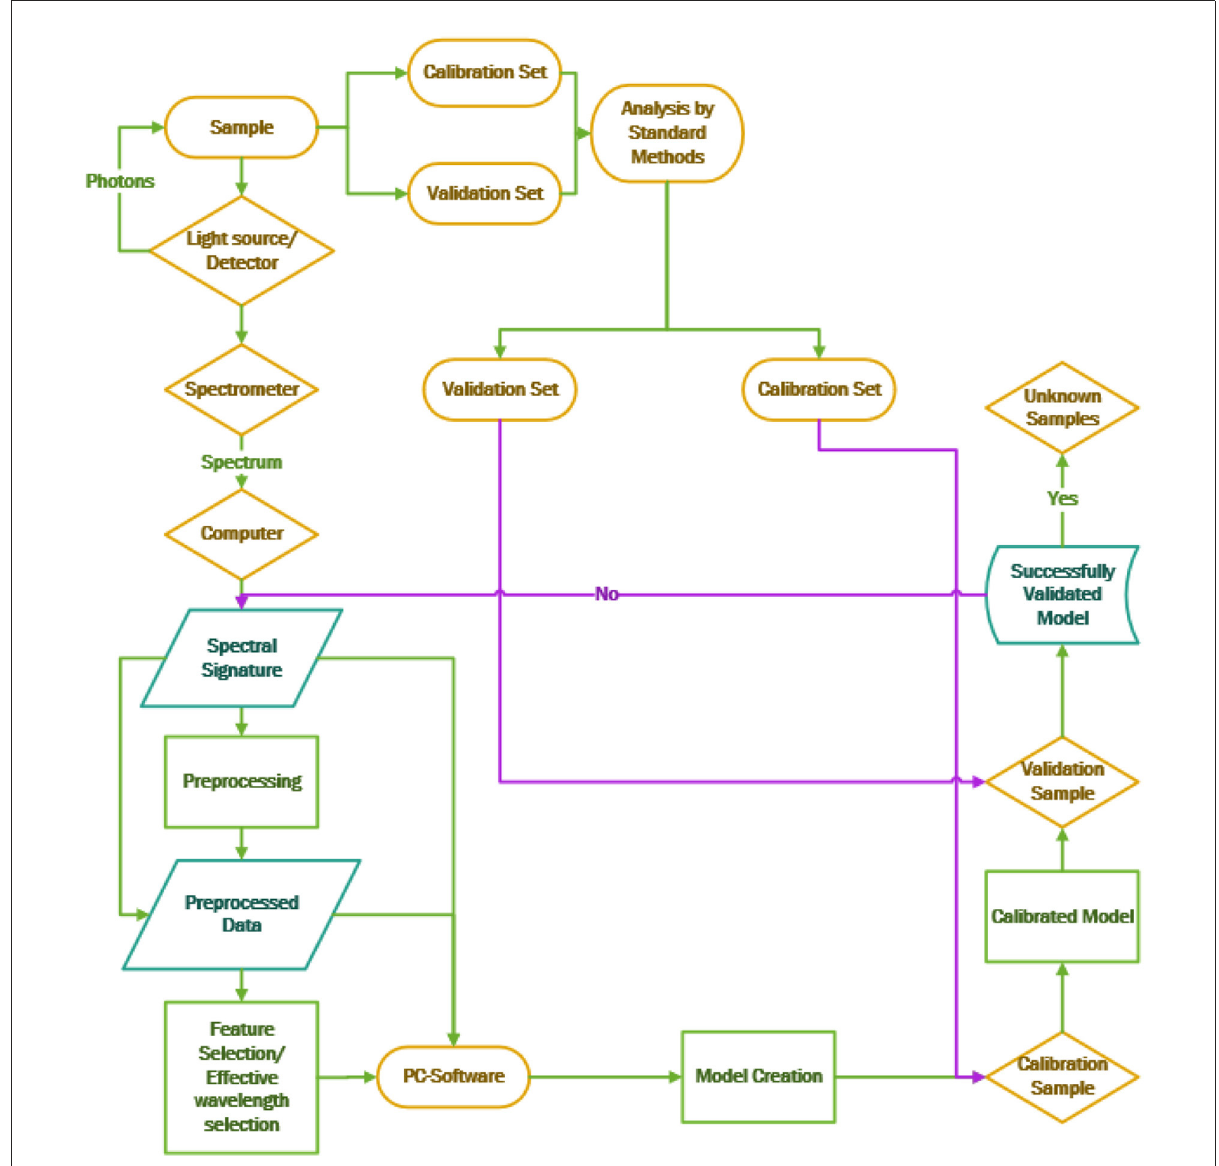
FIGURE2 Flow chart depicting the NIRS modeling